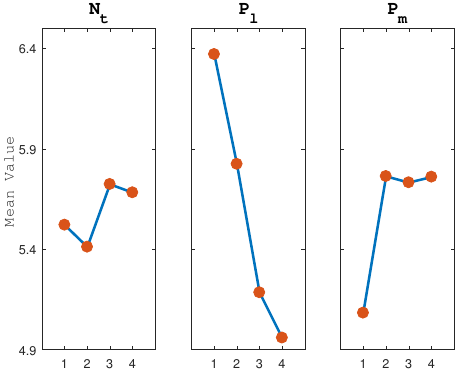
Figure 7. Factor levels. Table 4. Comparison of P l level.